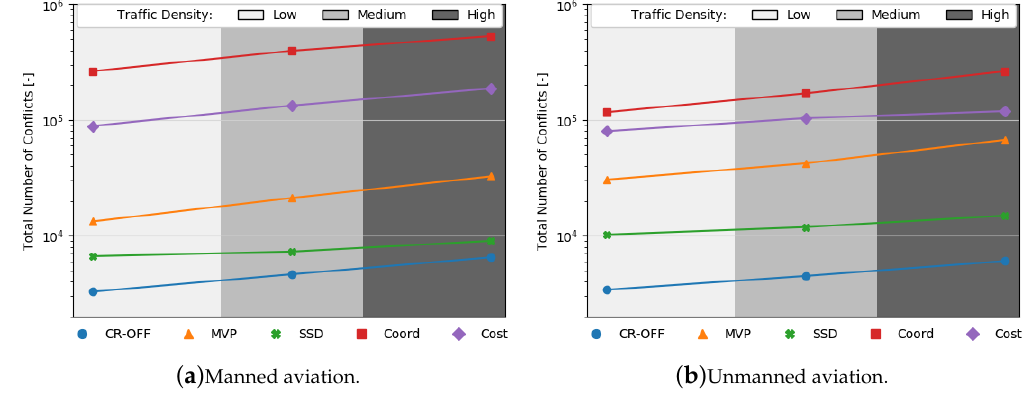
Figure 11. Total number of conflicts per CD&R